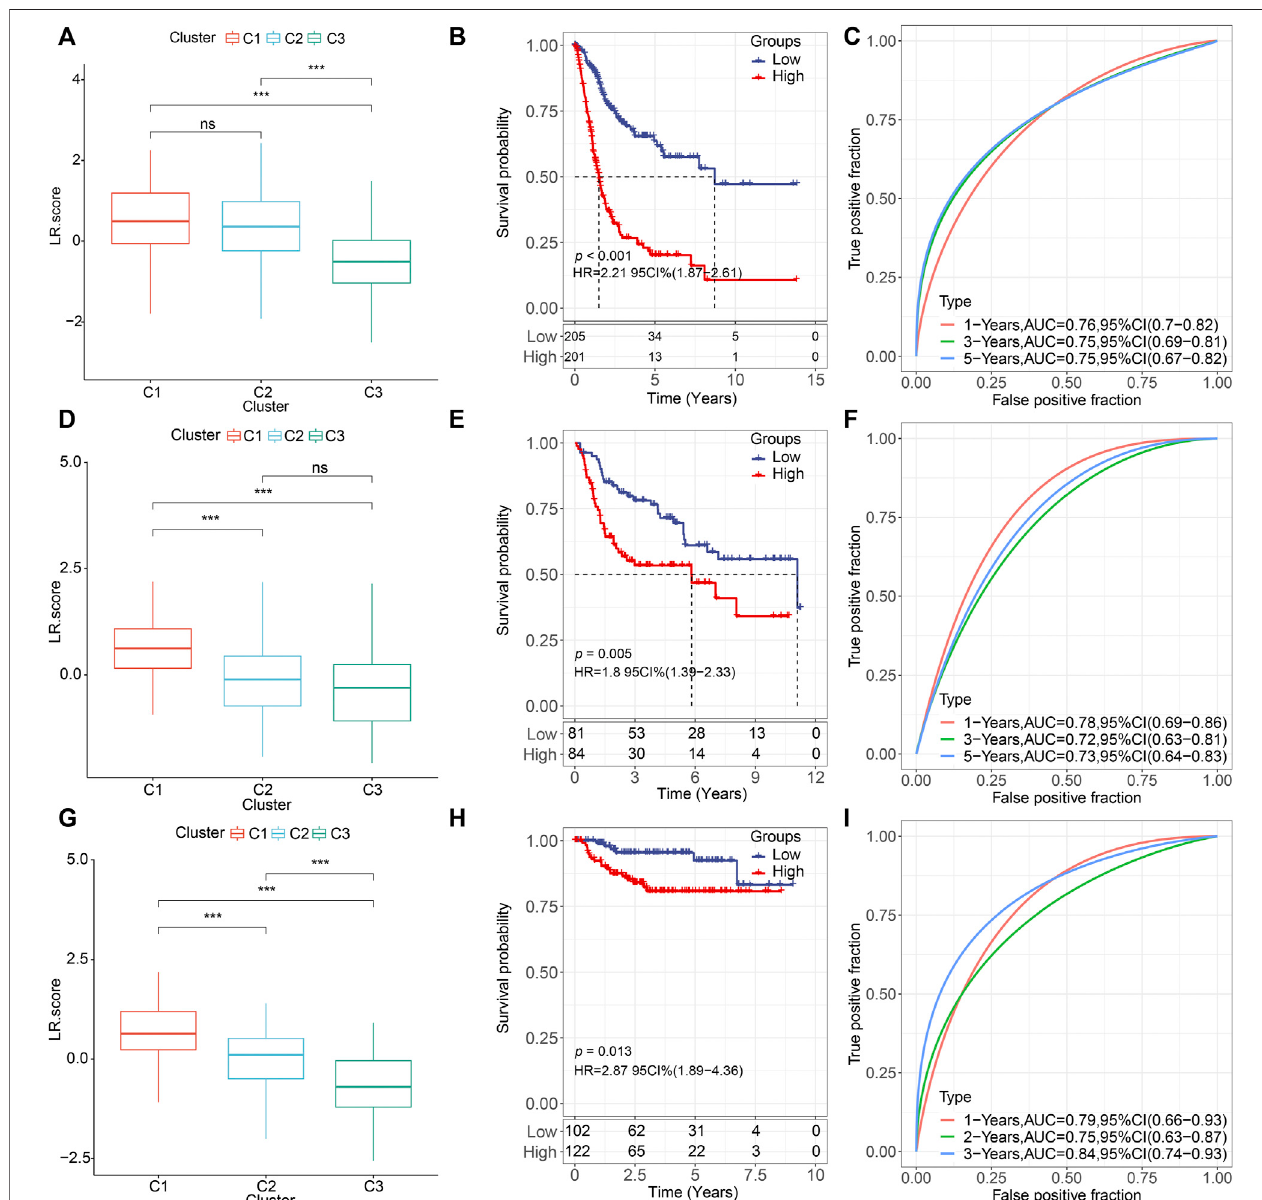
FIGURE 6 | Prognostic effect of LR. score (A,D,G) . Distributions of the LR. score in the three LR-based clusters in (A) TCGA (D) GSE135607, and (G) GSE32894 cohorts. ns, p > 0.05; * p < 0.05; ** p < 0.01; *** p < 0.001. Wilcoxon rank-sum test. (B,E,H) . Kaplan – Meier curve of the overall survival between low- and high-LR in (B) TCGA, (E) GSE135607, and (H) GSE32894 cohorts. (C) . ROC curve of the prognostic values of LR. score in TCGA cohort in 1-, 3-, and 5-year OS with AUC = 0.76, 0.75, and 0.75, respectively. (F) . ROC curve of the prognostic values of LR. score in TCGA cohort in 1-, 3-, and 5-year OS with AUC = 0.78, 0.72, and 0.73, respectively. (I) . ROC curve of the prognostic values of LR. score in TCGA cohort in 1-, 3-, and 5-year OS with AUC = 0.79, 0.75, and 0.84, respectively.